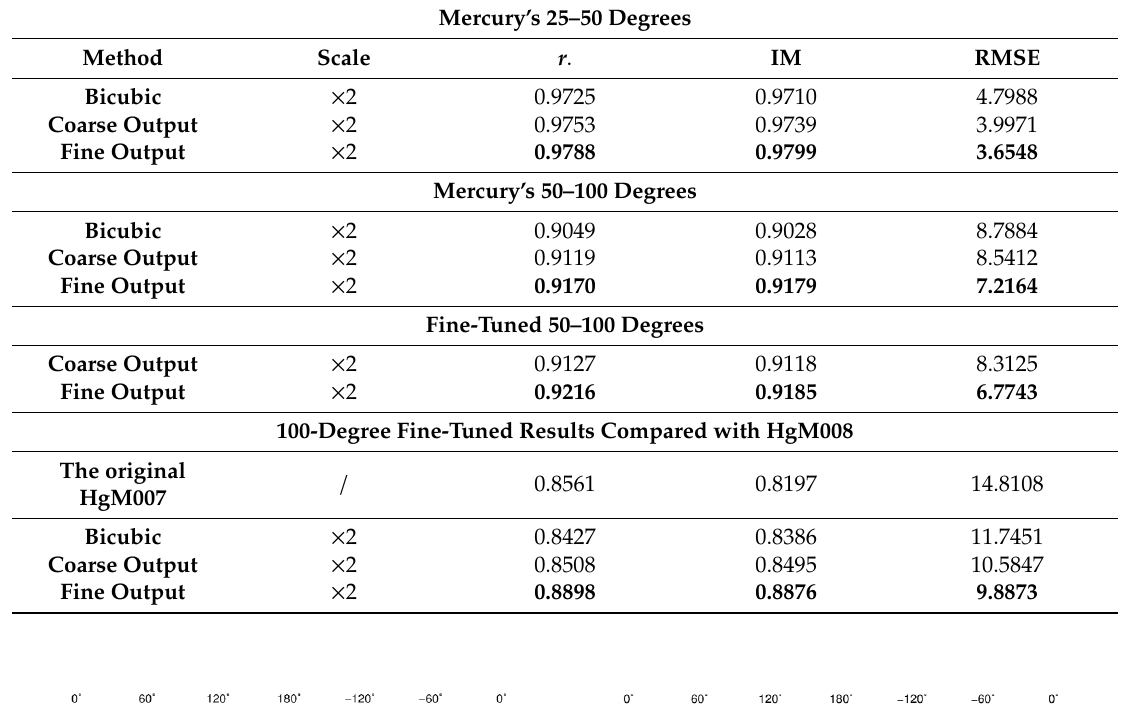
Table 4. Quantitative indicators of Experiment 2.